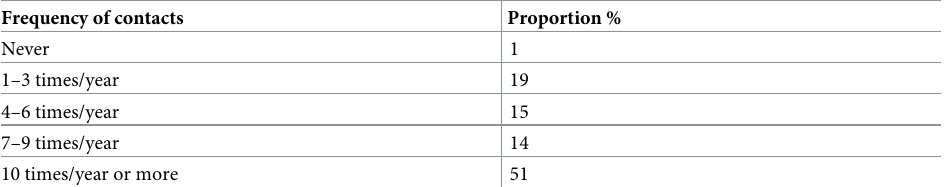
Table 4. Frequency of media contacts.